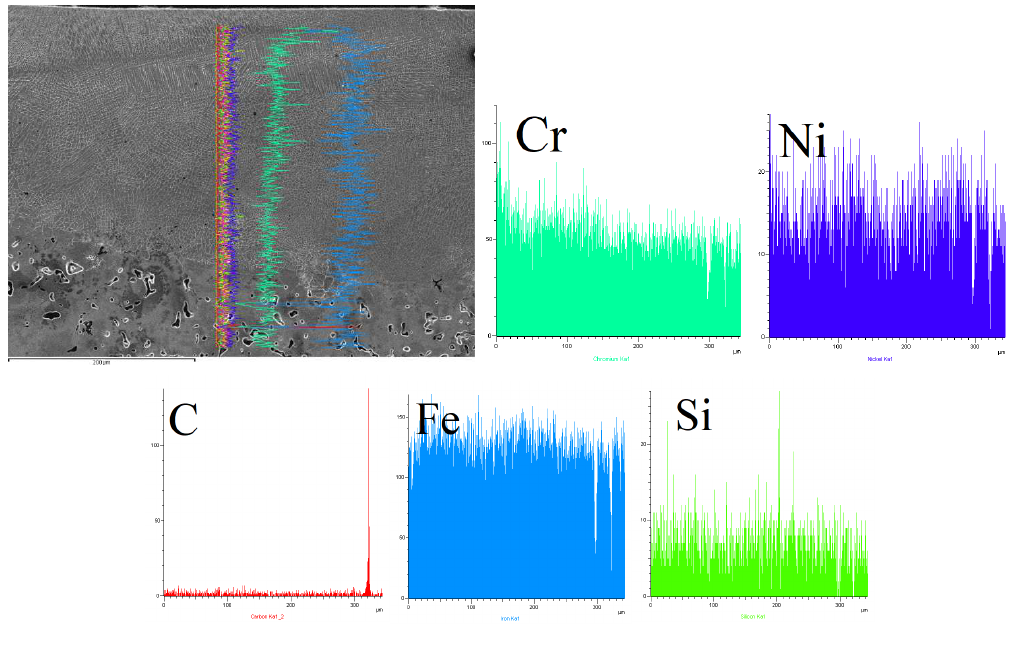
Figure 13. Line mapping analysis EDS on cross-section after laser alloying process for sample 3.